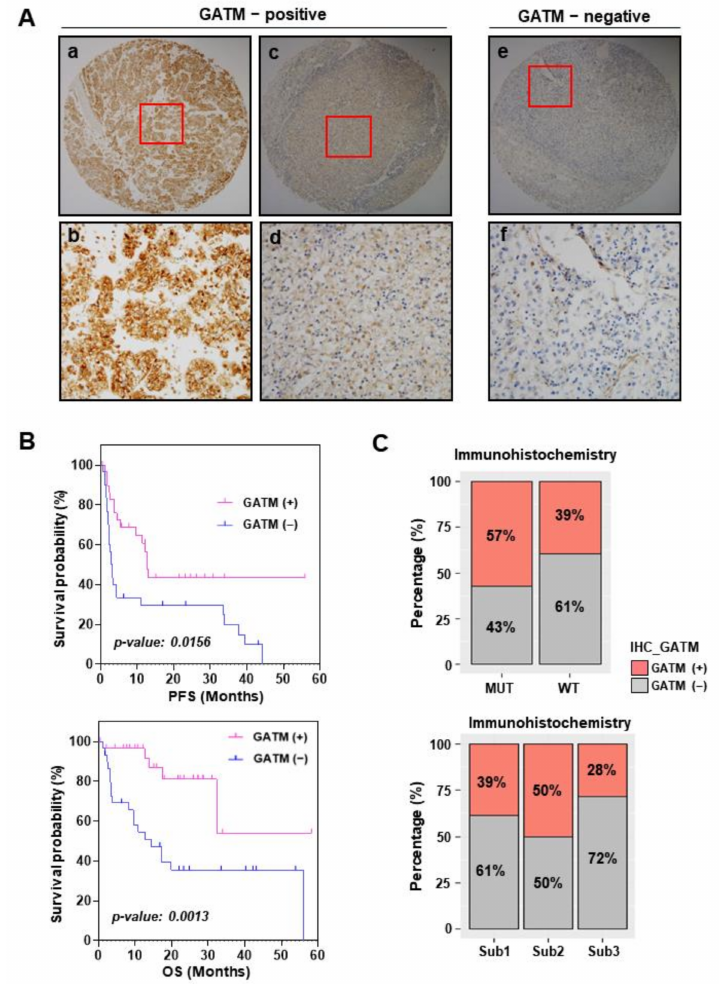
Figure 5. Status of GATM protein expression in immunohistochemistry are related to favorable survival. ( A ) Immunohistochemistry of GATM expression using tissue microarray of 51 patients with metastatic clear cell renal cell carcinoma treated by immune checkpoint blockades. The GATM- positive group includes “high expression” of GATM (a × 4, and b; × 20) and “low expression” of GATM (c; × 4, and d; × 20). The GATM-negative group includes “no expression” of GATM (e; × 4, and f; × 20). ( B ) Kaplan–Meier plot analysis of progression-free survival and overall survival based on the status of GATM protein expression. GATM (+) = GATM-positive group; GATM ( − ) = GATM-negative group. ( C ) Barplots show the percentage of both GATM-positive (+, crimson), and GATM-negative groups ( − , gray), respectively, in the patients with PBRM1 mutation vs. the patients without PBRM1 mutation (top), and each subtype